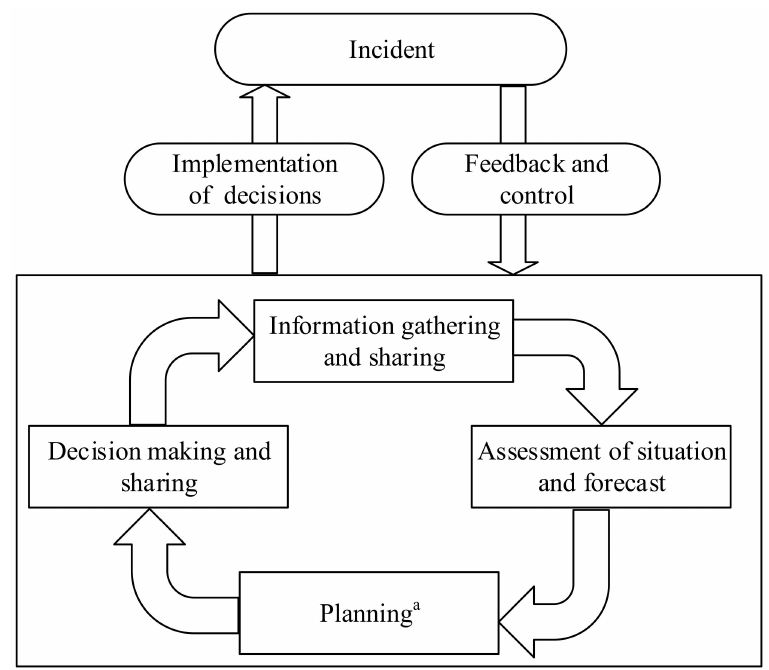
Figure 1. Example of command and control process in a single hierarchical organization with limited coordination needs. a with limited need for coordination with partners outside the organization.